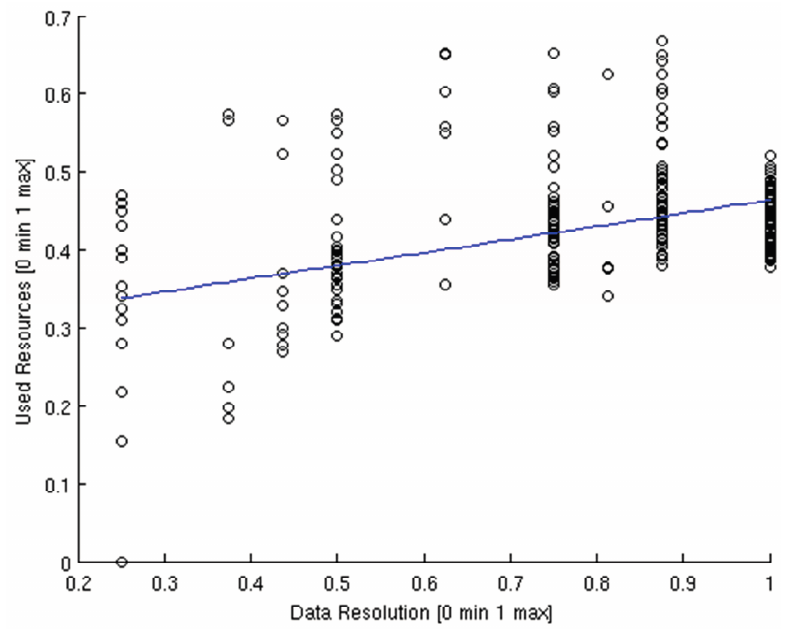
Figure 13. Data resolution vs. used resources.